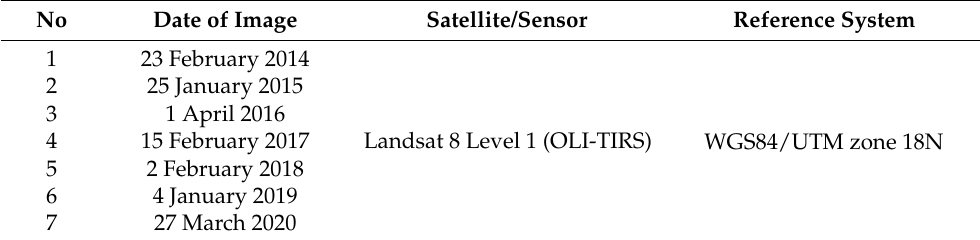
Table 1. Details of Landsat satellite imagery